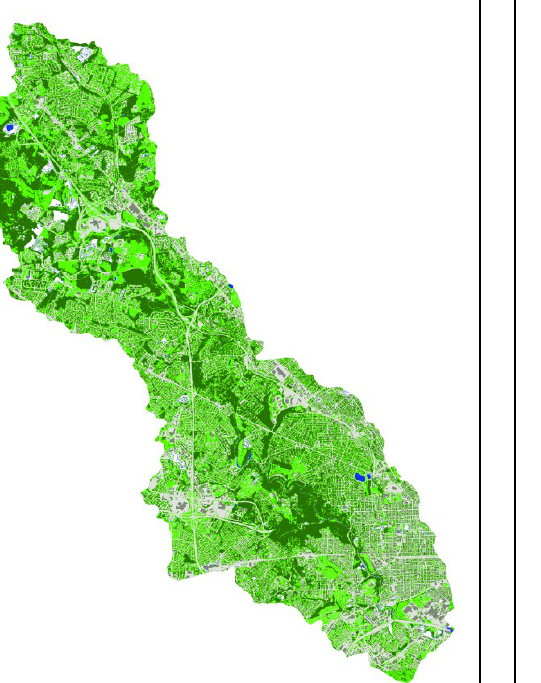
Figure 4. Land cover classification for the Gwynns Falls watershed in 1999 ( left panel) and 2004 ( right